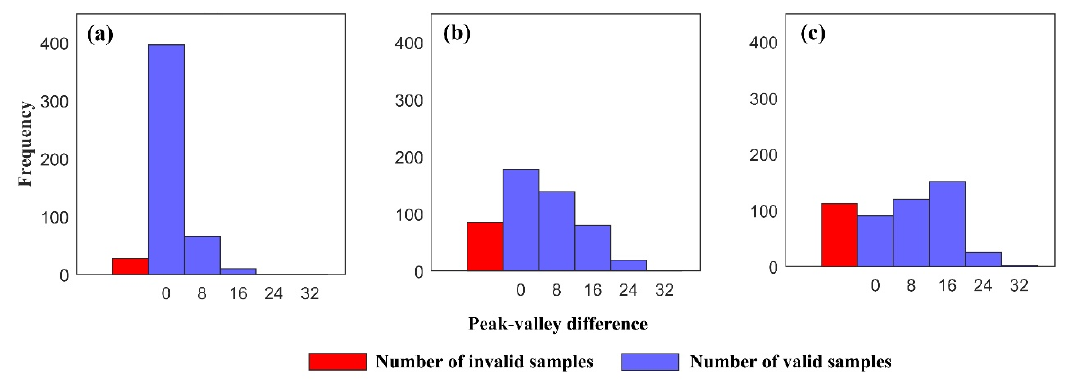
Figure 11. ( a ) Histogram of time difference between DYI peak and NDVI valley. ( b ) Histogram of time difference between RYI peak and NDVI valley. ( c ) Histogram of time differences between NDYI peak and NDVI valley. Invalid samples are the pixels without yellowness peak during the estimated flowering period.